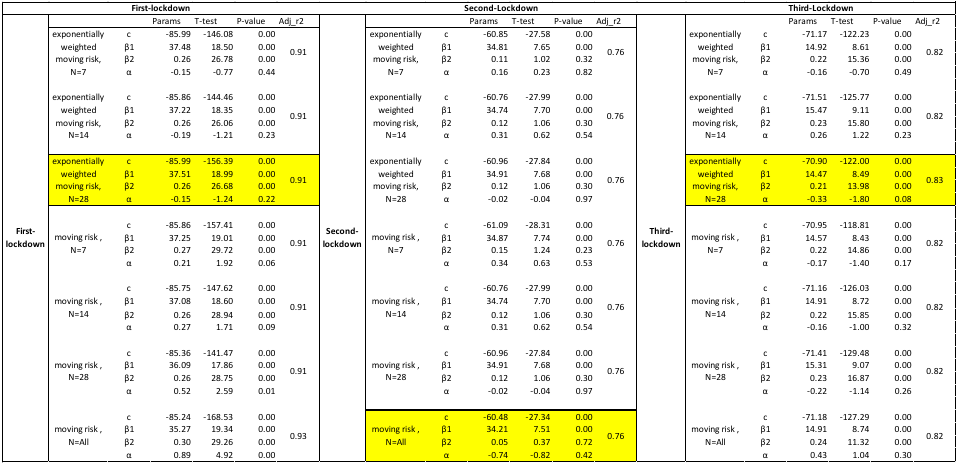
Figure A5. The linear model results of each generated risk perceptions in three lockdown periods.